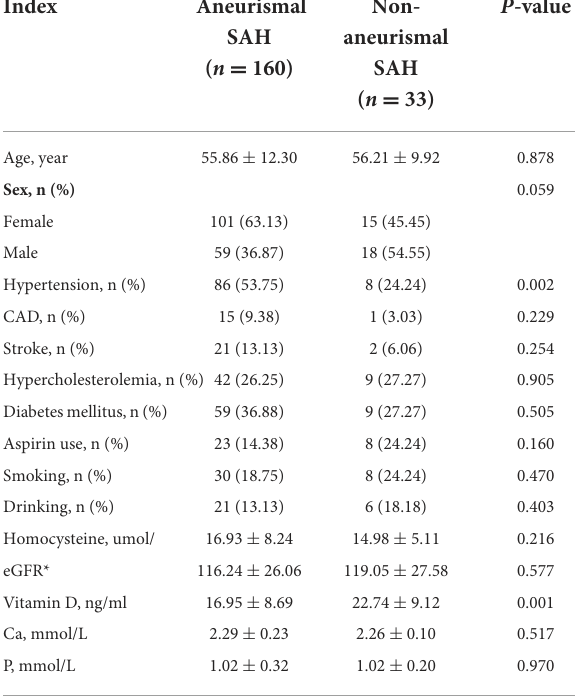
*Estimated glomerular filtration rate (eGFR), an indicator of baseline kidney function, was calculated with the Modification of Diet in Renal Disease formula. eGFR =